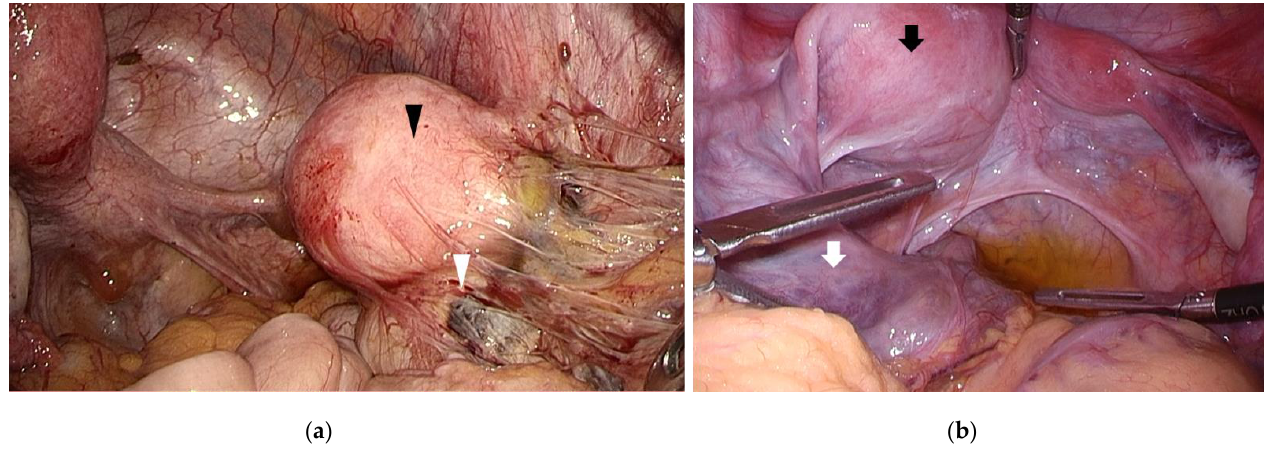
Figure 2. Congenital uterine anomaly and outflow obstruction. ( a ) A left unicornuate uterus with non-communicating functional horn (black arrowhead) was observed. An endometriotic cyst (white arrowhead) was found in the right ovary with inflammatory adhesion surrounding the right adnexa; ( b ) A right unicornuate uterus presenting with hematometra accompanying a non-communicating functional horn (black arrow). Left hematosalpinx (white arrow) and left endometriotic cyst was observed.